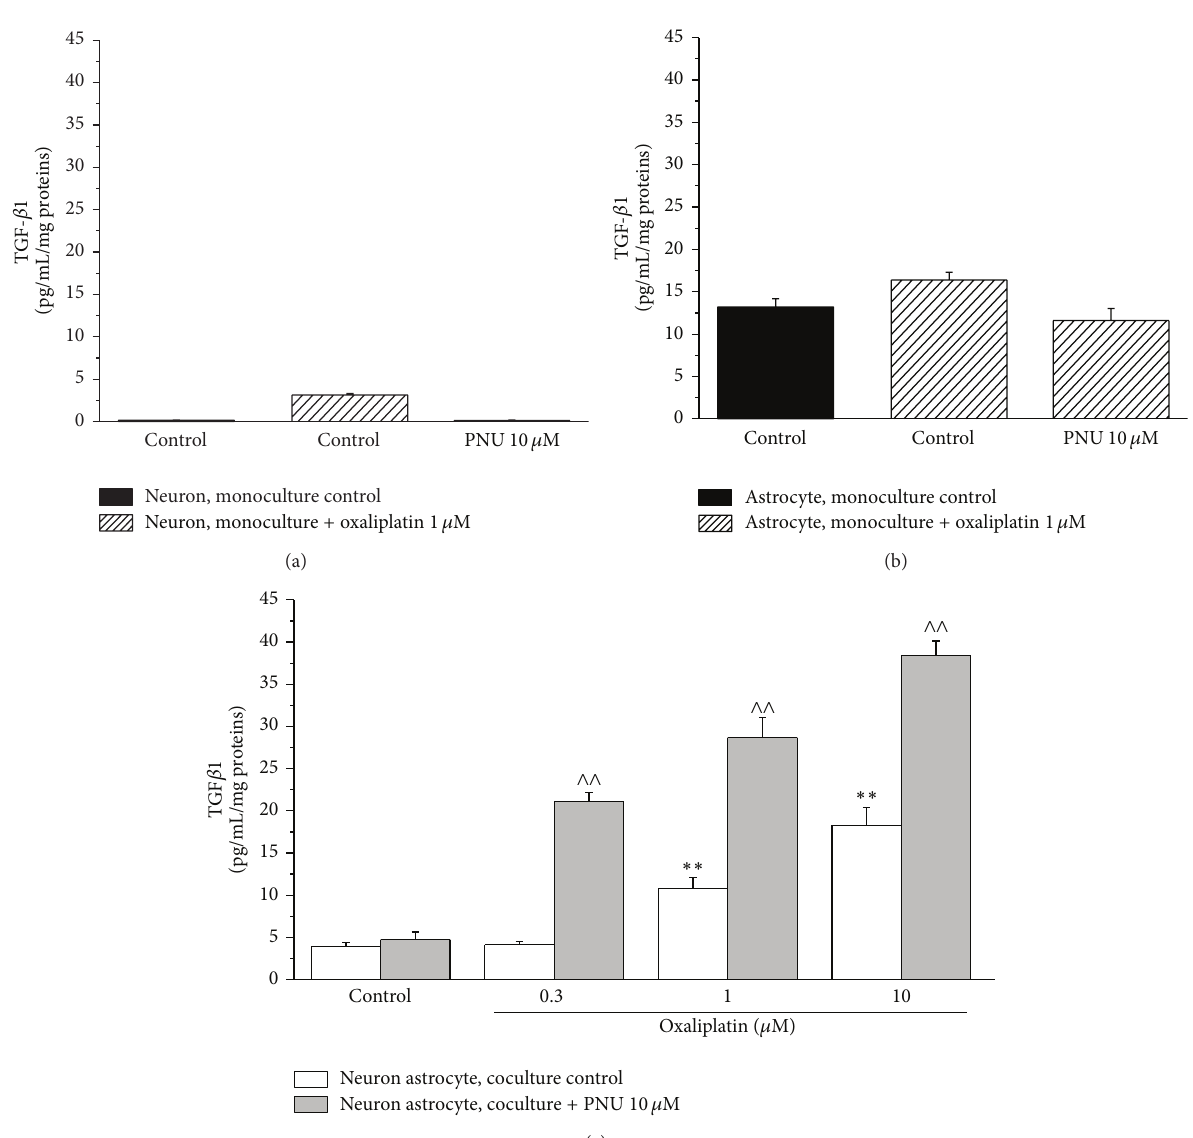
Figure 4: TGF- 𝛽 1 dosage. The concentration of the anti-inflammatory cytokine TGF- 𝛽 1 was measured in the culture medium of (a) neuron, (b) astrocyte monoculture, and (c) neuron astrocyte coculture. ((a) and (b)) Cells were treated with 1 𝜇 M oxaliplatin (48h) in the absence or presenceof10 𝜇 MPNU.(c)Coculturesweretreatedwithincreasingconcentrationsofoxaliplatin(0.3,1,and10 𝜇 M)intheabsenceorpresence of 10 𝜇 M PNU. Results are expressed as pg/mL of TGF- 𝛽 1 per mg of proteins. Values are expressed as the mean ± S.E.M. of 6 experiments. One-way ANOVA was performed followed by a Bonferroni significant difference procedure. ∗∗ 𝑃 < 0.01 versus control; ∧∧ 𝑃 < 0.01 versus oxaliplatin